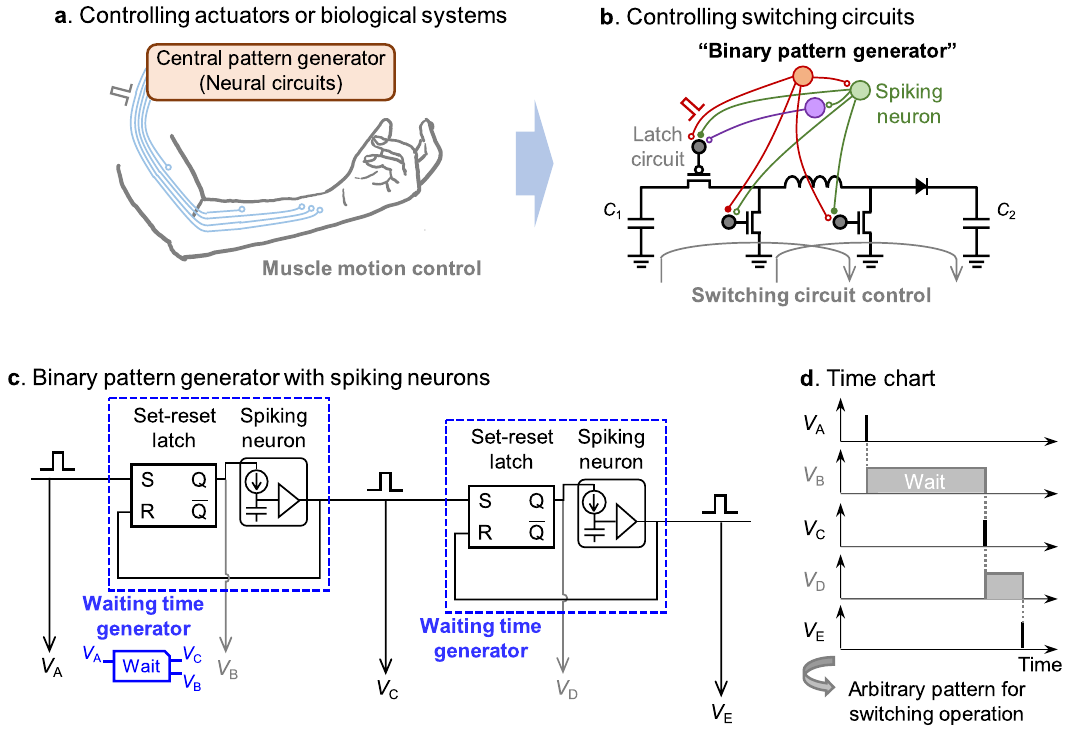
Figure 1. Binary pattern generator. ( a ) A central pattern generator in the human neural network which controls biological motors. ( b ) A concept of an artificial pattern generator which controls switching circuits for DC-DC voltage conversion. ( c ) A binary pattern generator, a specially designed pattern generator for purpose of controlling switching circuits. It consists of a chain of waiting time generators with a wide range of preprogrammed waiting times. ( d ) The spike or bit output signals from the binary pattern generator. The length of the bit signal corresponds to the preprogrammed waiting time of each waiting time generator. This bit signal is directly used for the gate control in the switching